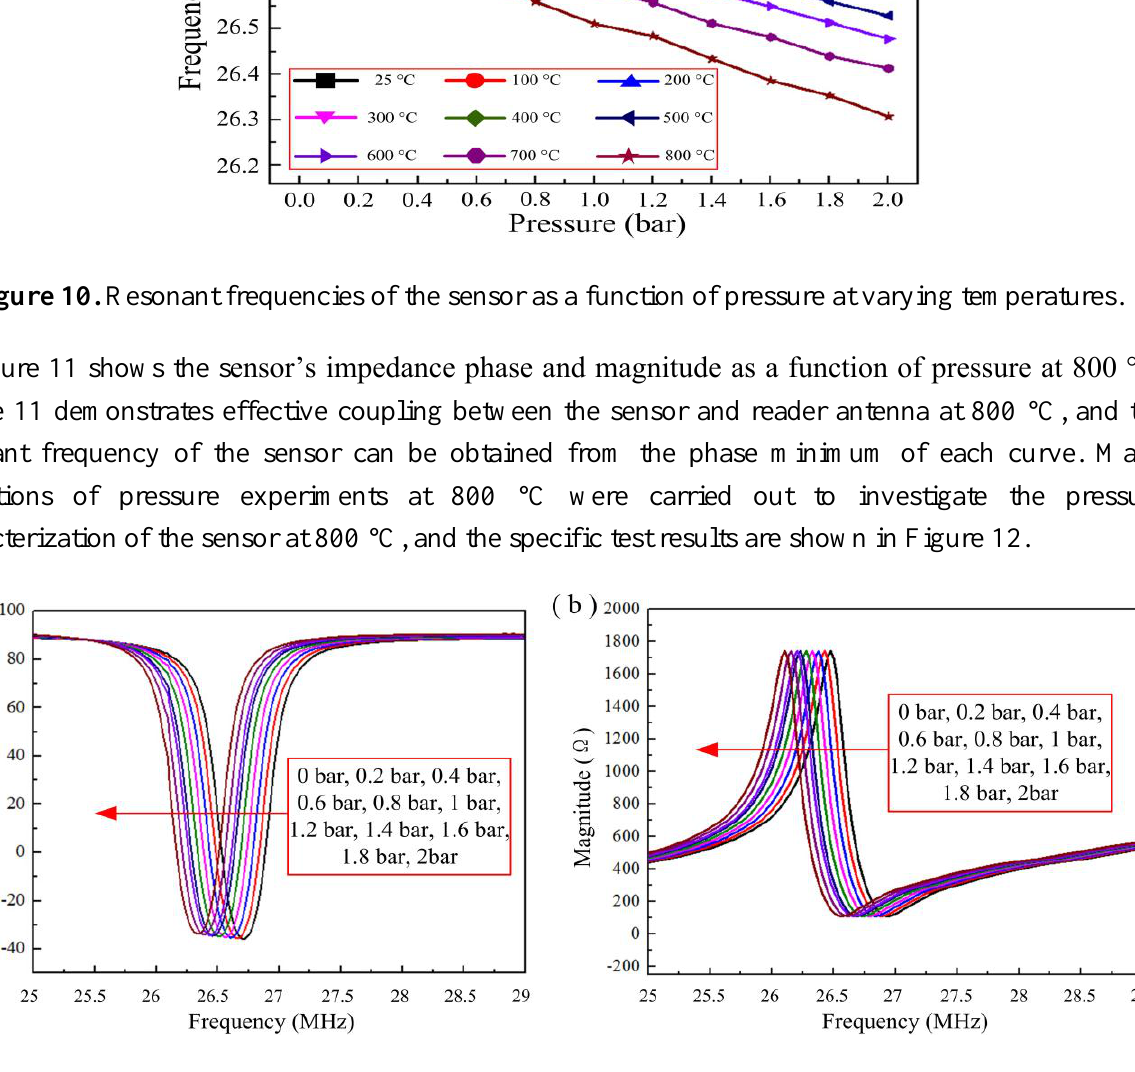
Figure 11. Impedance ( a ) phase and ( b ) magnitude, in response to different pressures at 800